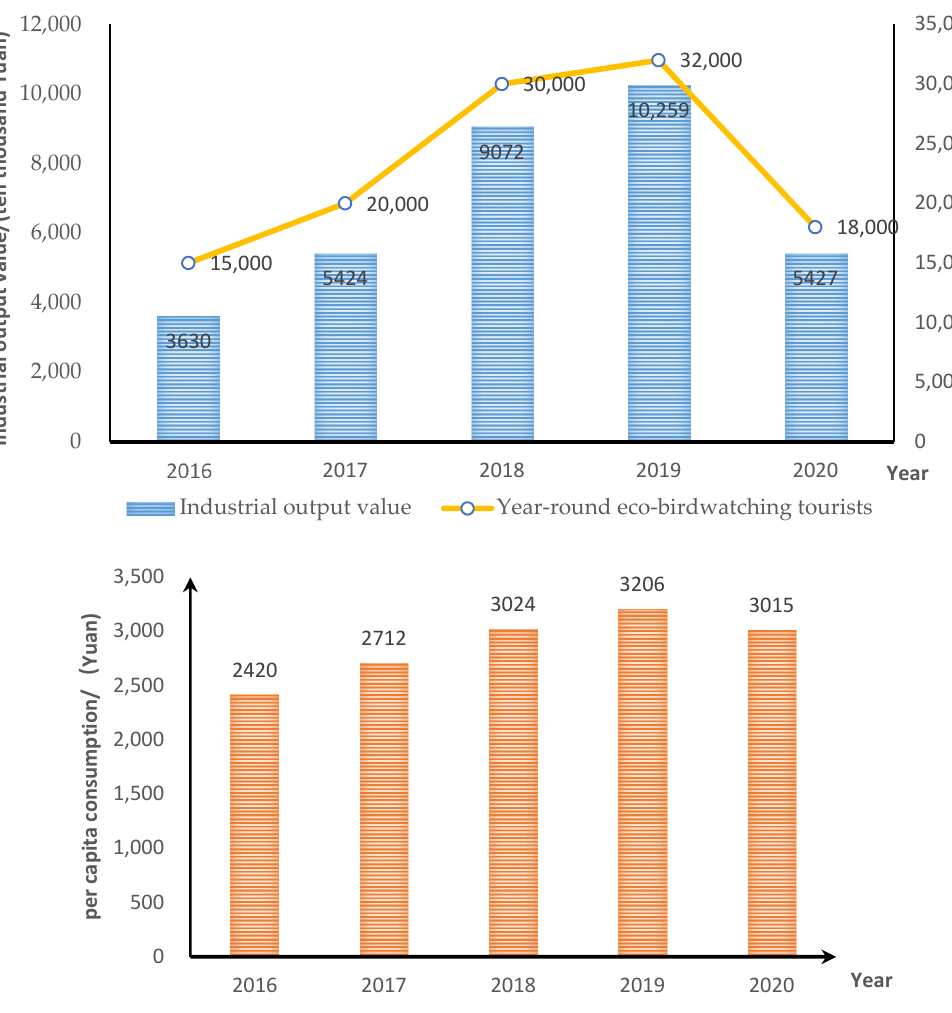
Figure 2. Numbers and output value for eco-birdwatching tourism in Mingxi County.